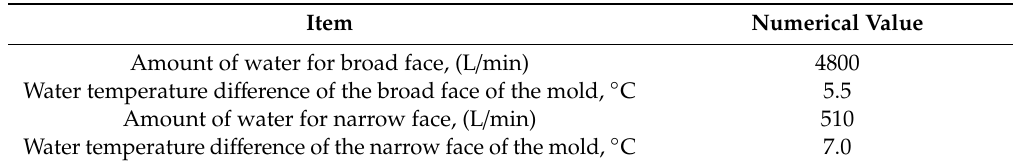
Table 1. The related process of the